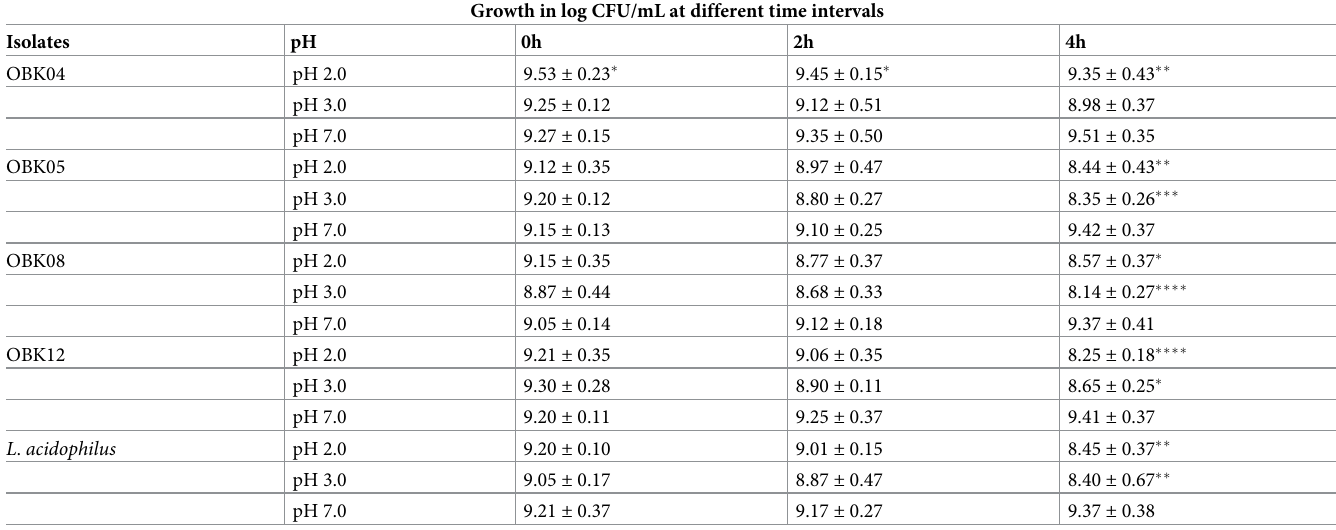
Table 1. Acid tolerance ability of Lactic acid bacterial (LAB) isolates. Growth in log CFU/mL at different time